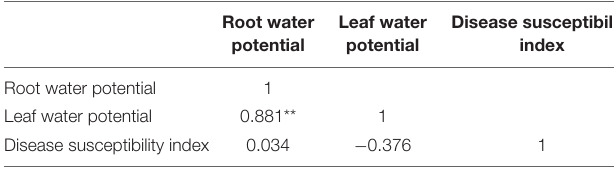
TABLE 1 | Correlation analysis among disease susceptibility index, root, and leaf water